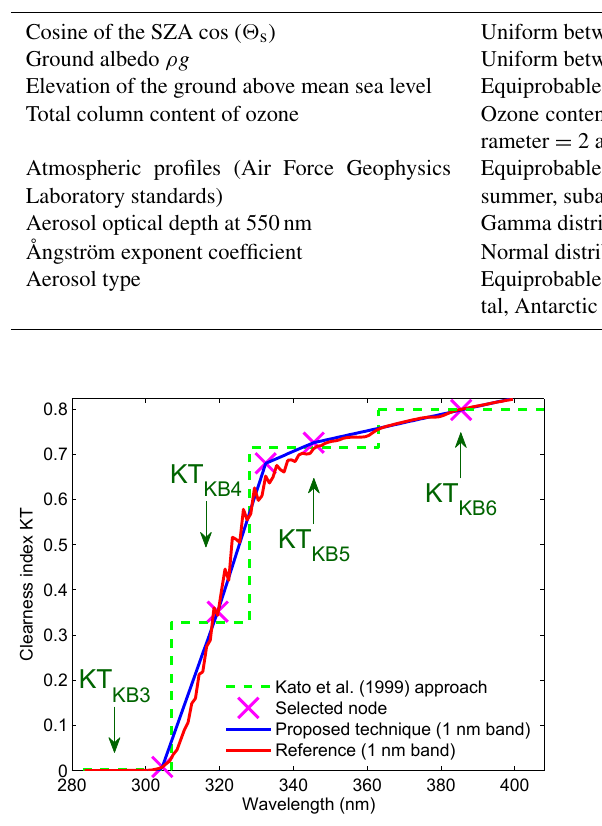
Figure 1. Illustration of the resampling technique.